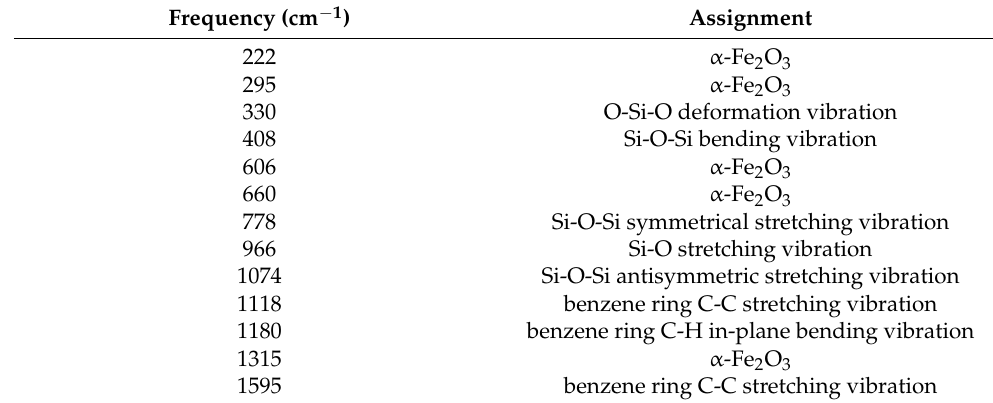
Table 4. Assignments of the Raman shifts of opal